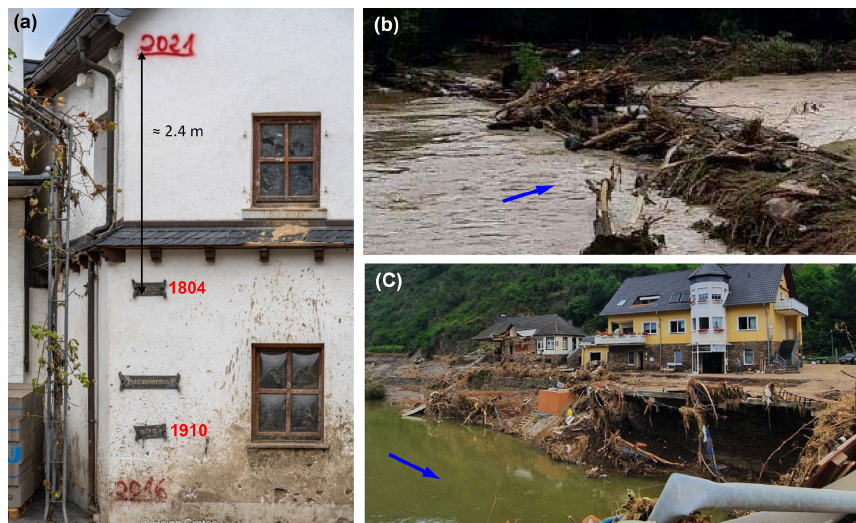
Figure 7. (a) Flood marks in the municipality of Dernau (Ahrweiler district), including the floods of 1804, 1910, 2016, and 2021 (© Heinz Grates). (b) One of the collapsed bridges of the Ahr valley railroad (Ahrtalbahn) with trees eroded from the landscape (© Mar- tin Seifert) and (c) bank erosion and collapsed road bridge, both in the municipality of Altenahr (Altenburg; © Bettina Vier). Blue arrows show the river flow